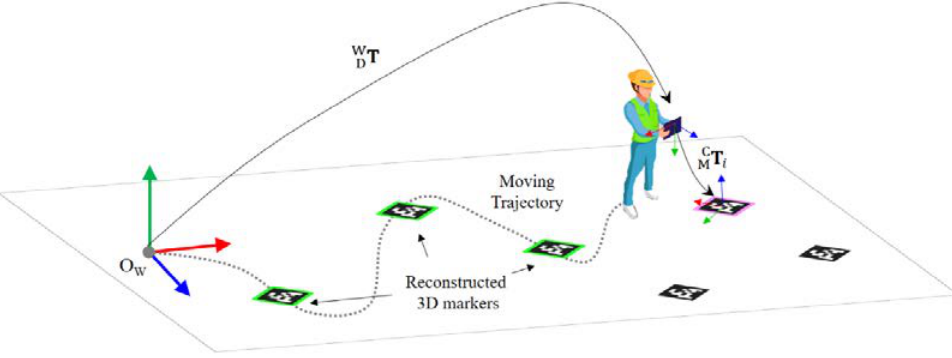
Figure 11. Concept of marker recovery in world coordinate system using Tango tracker.